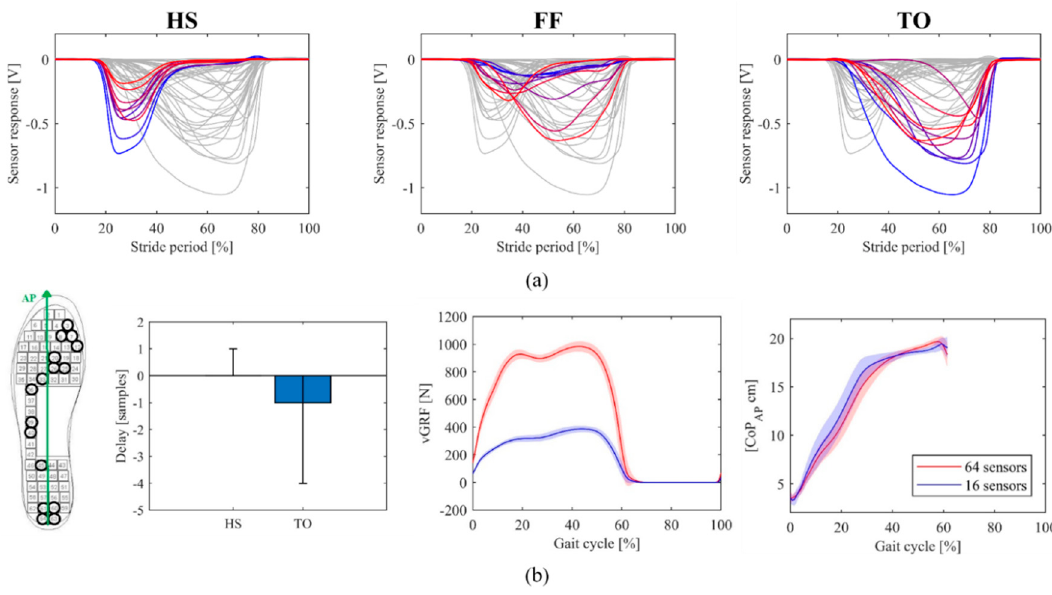
Figure 3. ( a ) Selection of the 10 most relevant sensors for each gait event for a sample subject. ( b ) Sensor placement and offline performance of the configuration with 16 sensors with respect to the one with 64.